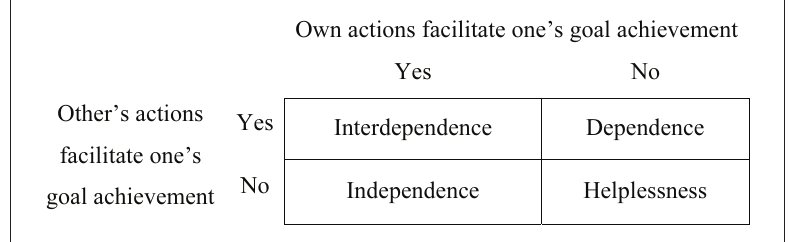
Figure 1. Interrelations among individuals (Johnson, Johnson, 2005)